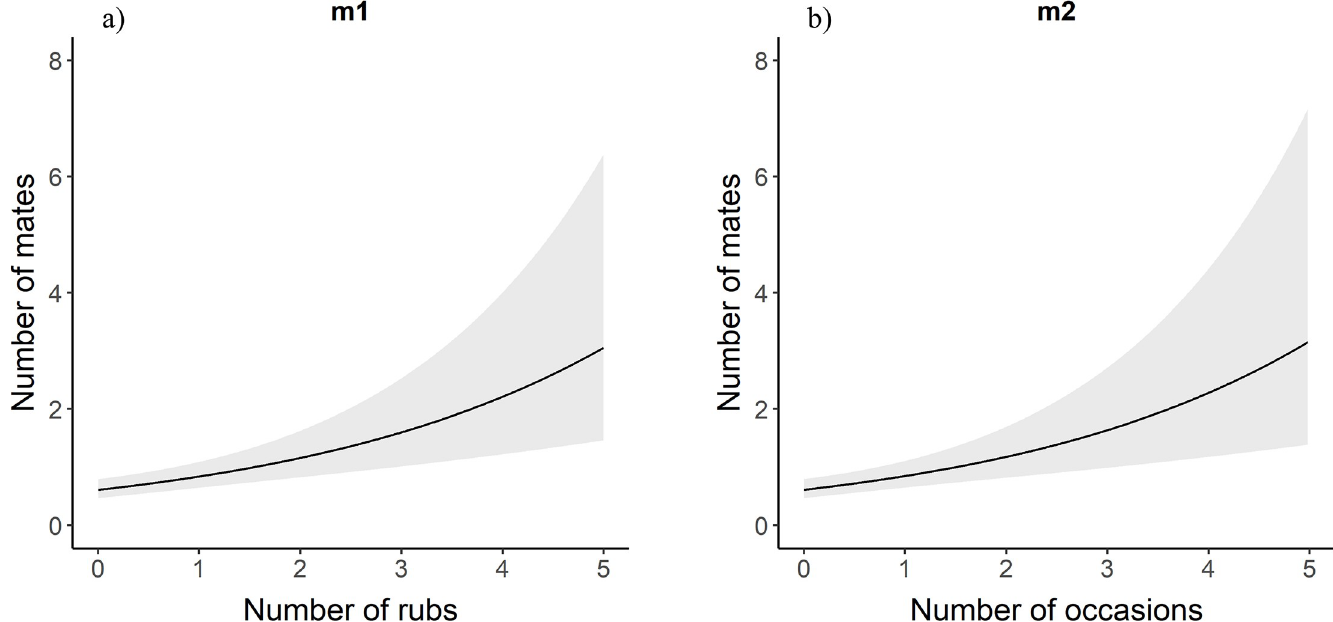
Fig 3. m1 and m2. Poisson regression response curves showing the relationship between the number of mates a male brown bear had and the number of rub objects (a) at which and sampling occasions (b) during which it was detected. 95% confidence intervals are in grey. Data are from southwestern Alberta 2011–2014.